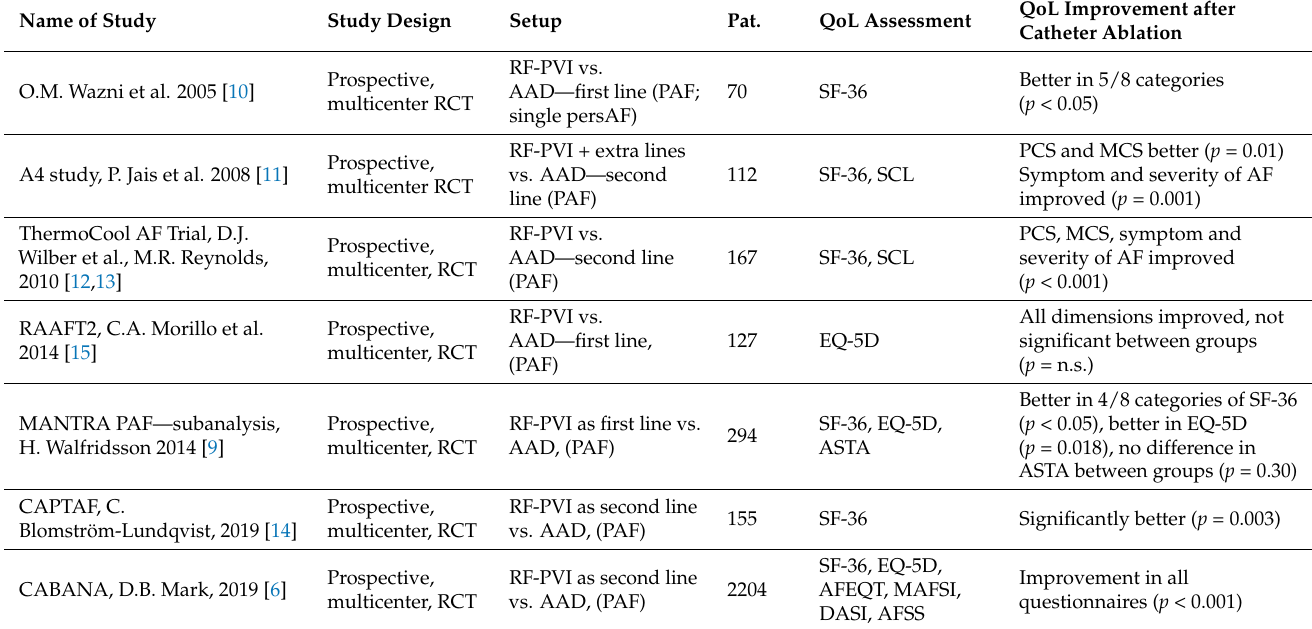
Table 2. Studies concerning the impact of catheter ablation on QoL in paroxysmal AF (RF-PVI: radiofrequency-pulmonary vein isolation, AAD: antiarrhythmic drug, RCT: randomized controlled trial, PAF: paroxysmal atrial fibrillation, persAF: persistent atrial